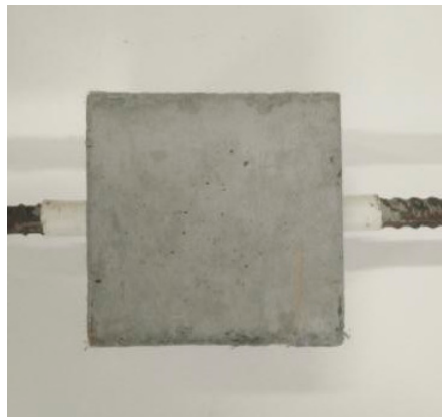
Figure 1. Tested specimens. Table 2. Specimen design and test results.